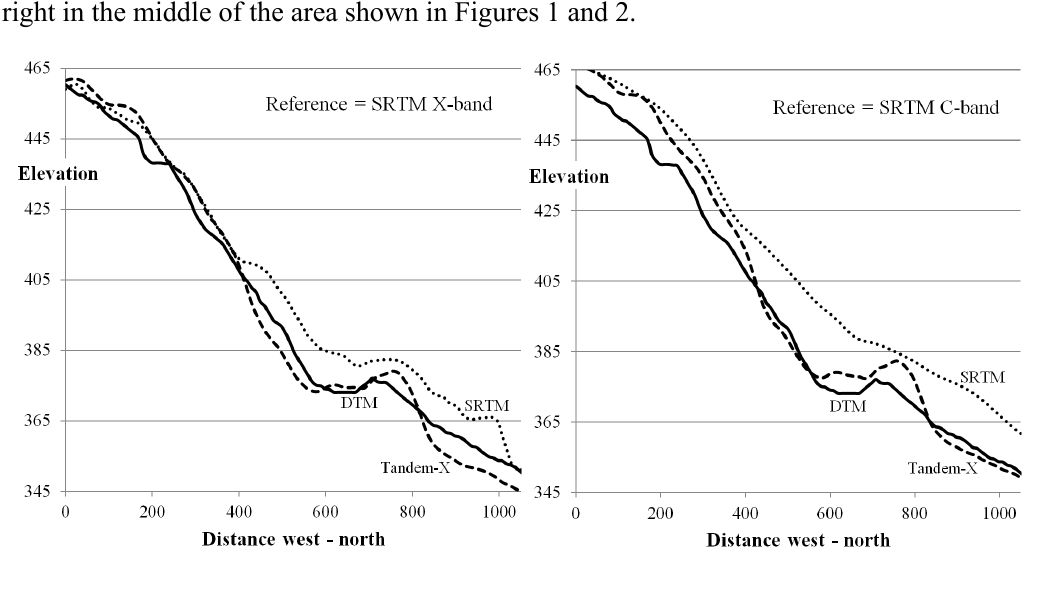
Figure 3. Profiles of the Digital Elevation Models (DEMs) along a 1,000 m long transect from east to west with Tandem-X processed with the X-band SRTM DSM as a reference ( Left ) and the C-band SRTM DSM as a reference ( Right ). The transect goes from left to right in the middle of the area shown in Figures 1 and